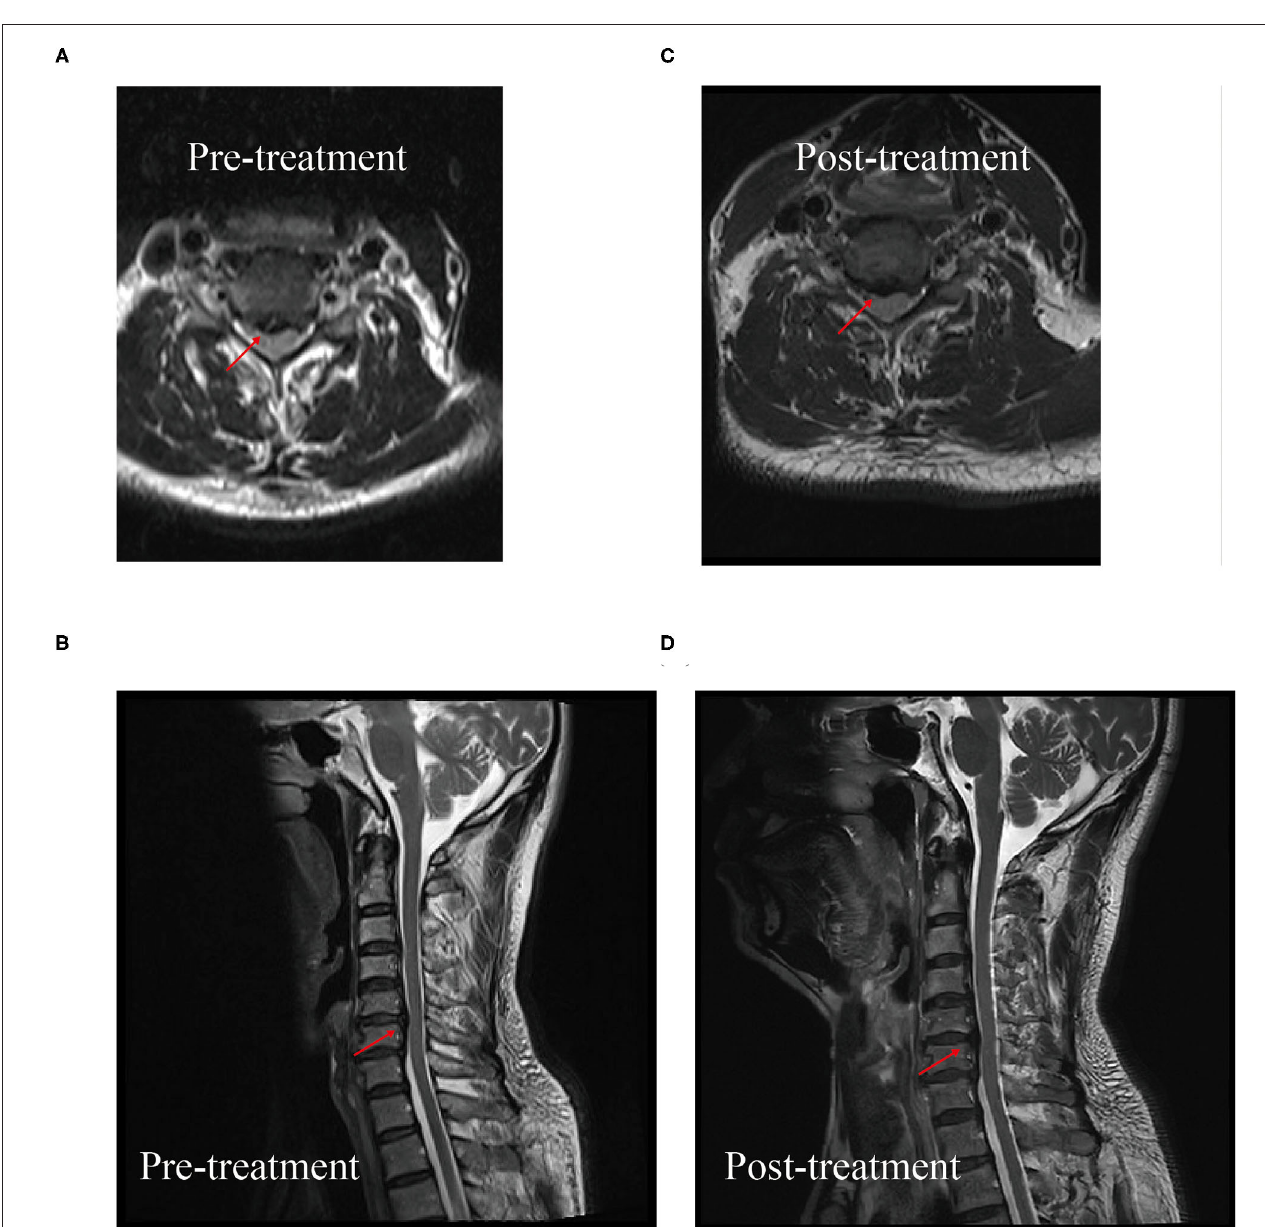
FIGURE 6 | Comparison of MRI between pre- (A,B) and post-treatment (C,D) in a male patient who underwent coblation surgery. The red arrow indicates the cervical disc herniation in sagittal plane.